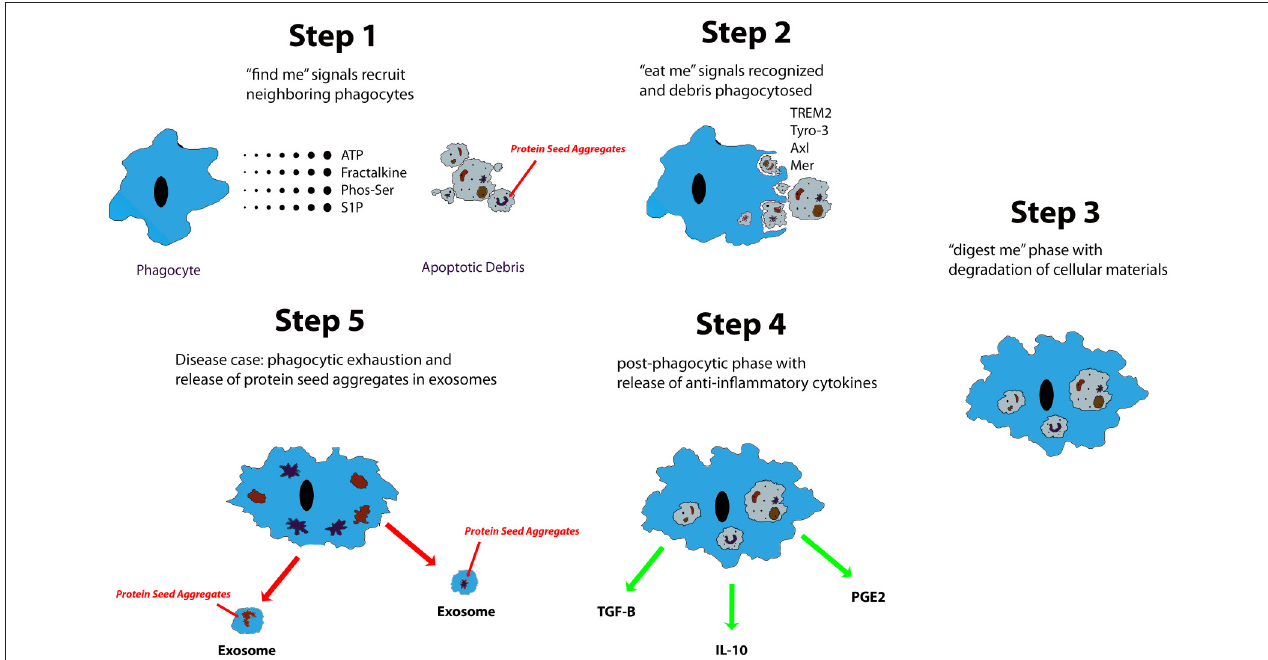
FIGURE 1 | Described are five steps of apoptotic cell clearance via phagocytes. Trace chemicals and molecules associated with cell necrosis and apoptosis stimulate the chemotaxis of phagocytes up their concentration gradient to the source. From there, the phagocyte engulfs the apoptotic debris and begins degradation. Eventually, it will release anti-inflammatory and reparative signals such as TGF- β , IL-10, and PGE2. In neurodegenerative diseases of protein aggregation, protein seed aggregates are packaged into exosomes where they can be shuttled to different regions of the